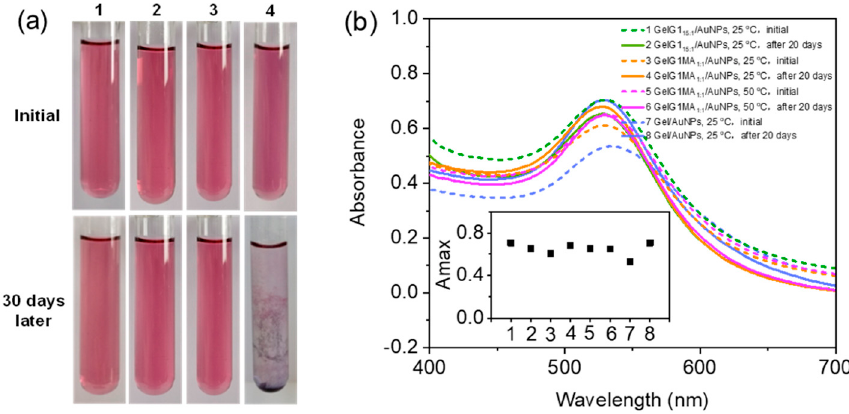
Figure 7. Stability of AuNPs in aqueous solutions. ( a ) Photographs of solutions of GelG1 15:1 /AuNP , 25 °C ( 1 ), GelG1MA 1:1 /AuNP , 25 °C ( 2 ), GelG1MA 1:1 /AuNP , 50 °C ( 3 ), and Gel/AuNP , 25 °C ( 4 ). ( b ) UV/vis spectra of the polymer/AuNPs solutions stored over different periods at room temperature. The inset shows the maximum absorbance with storage time.